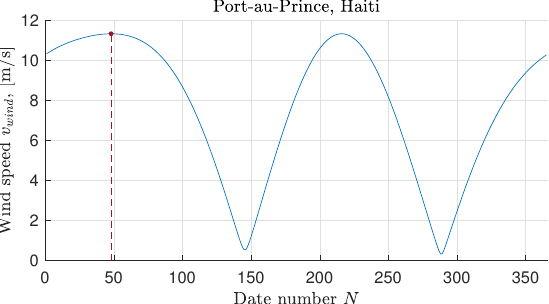
Figure 11. Yearly variability in airstream speed (evaluated at midnight of each day) at 18.059 km altitude above Port-au-Prince, Haiti (18 ◦ 34 (cid:48) 31 (cid:48)(cid:48) N, 72 ◦ 17 (cid:48) 41 (cid:48)(cid:48) W).